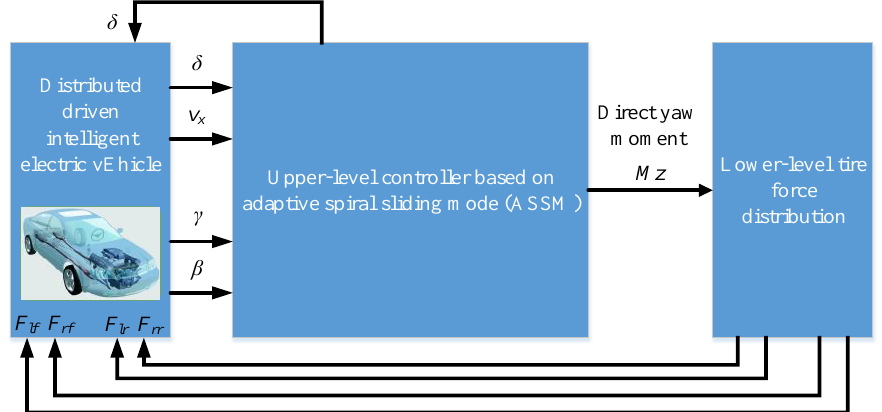
Figure 4. Structure of the hierarchical control.